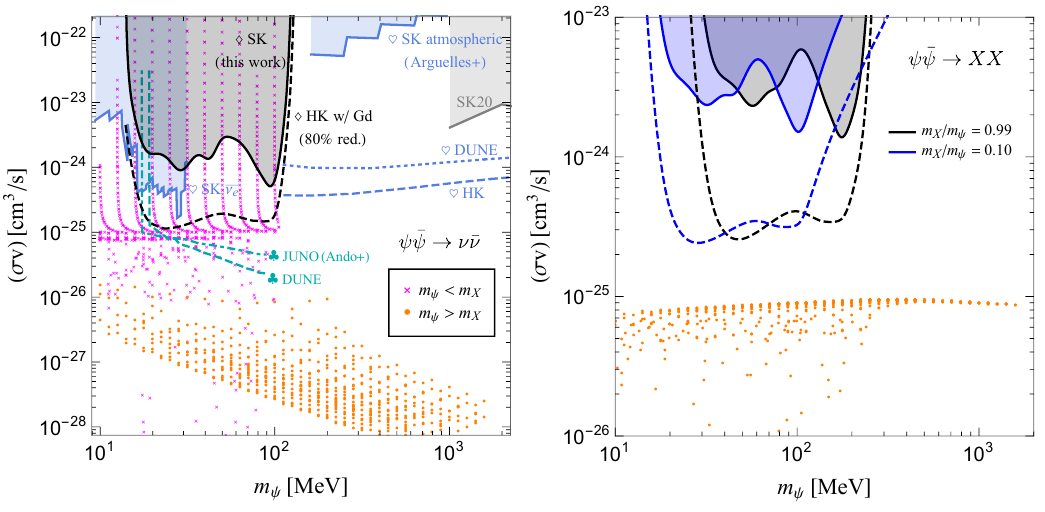
Figure 6 . The predicted annihilation cross section for (cid:22) ! (cid:23) (cid:22) (cid:23) (left) and (cid:22) ! XX (right)